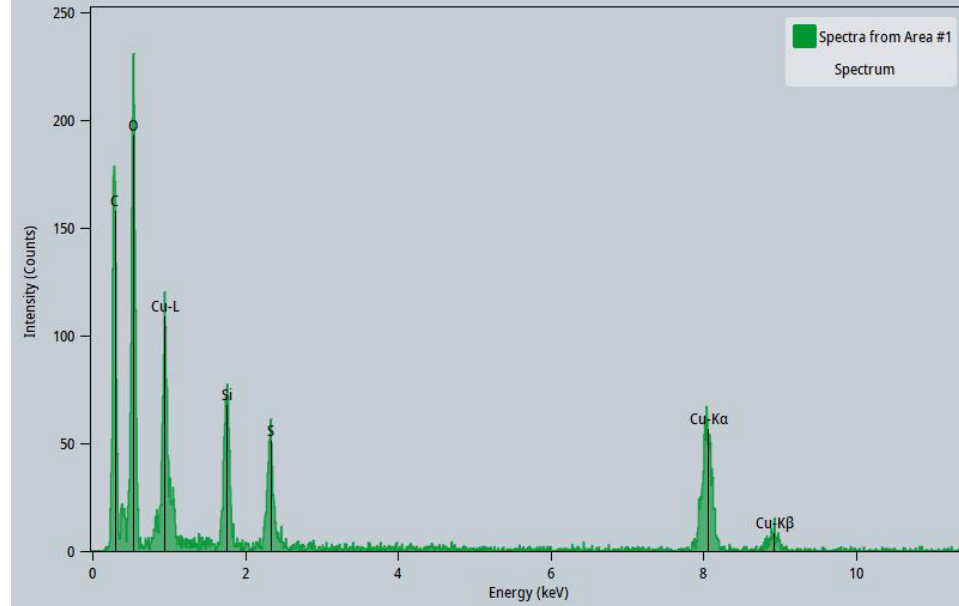
Figure 7. EDX Spectrum of 15% PAN/DMF/CuNP Colloidal Solution.